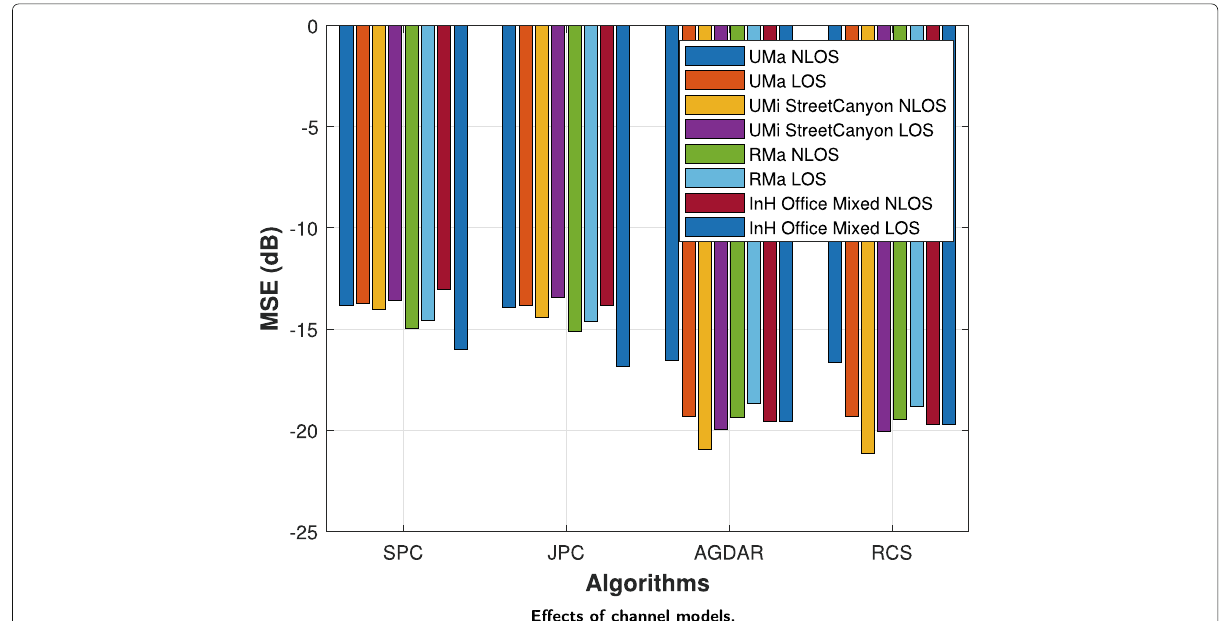
Fig. 11 Effects of channel models. MSE under different channel models with SNR of 10 dB for UPA with N t = 8 × 8 at the BS and N r = 2 × 2 at the UE, and M 0 = M 1 = 10 and M 2 = M 3 =